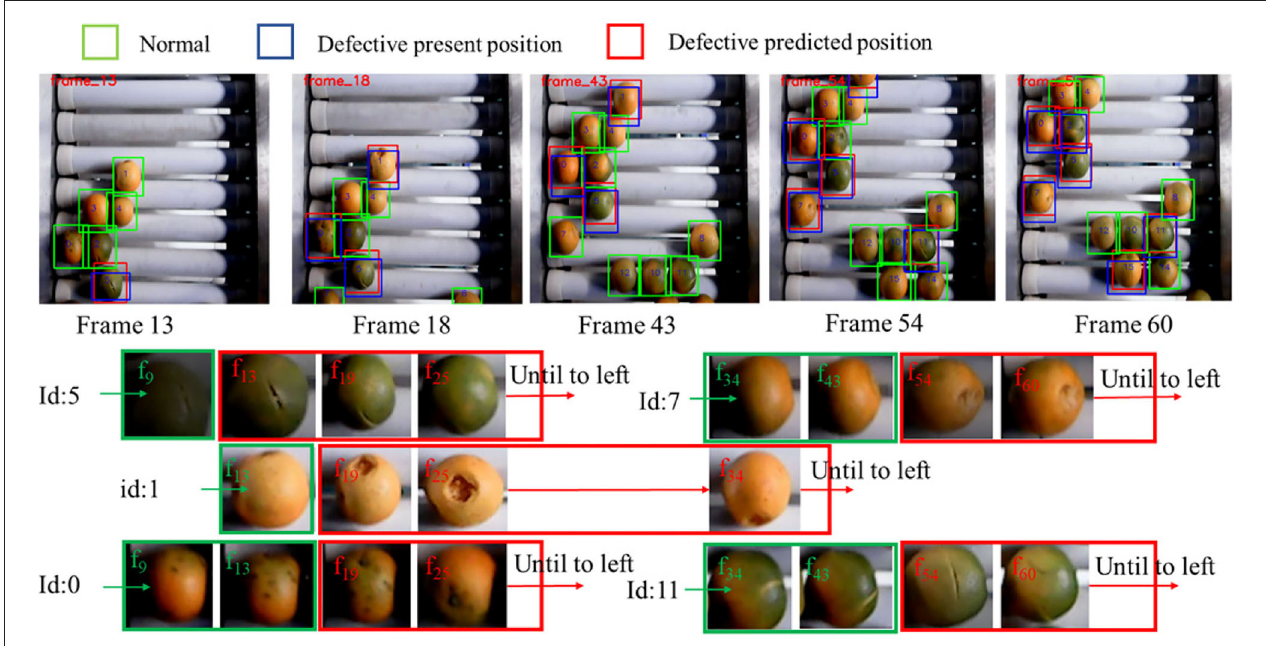
FIGURE 9 | Defective detection and tracking results by using the developed methods. The tracking series of five identified defective mandarins are shown in figure. Green box stands that this mandarin is identified as normal case, while red box stands that this mandarin is identified as